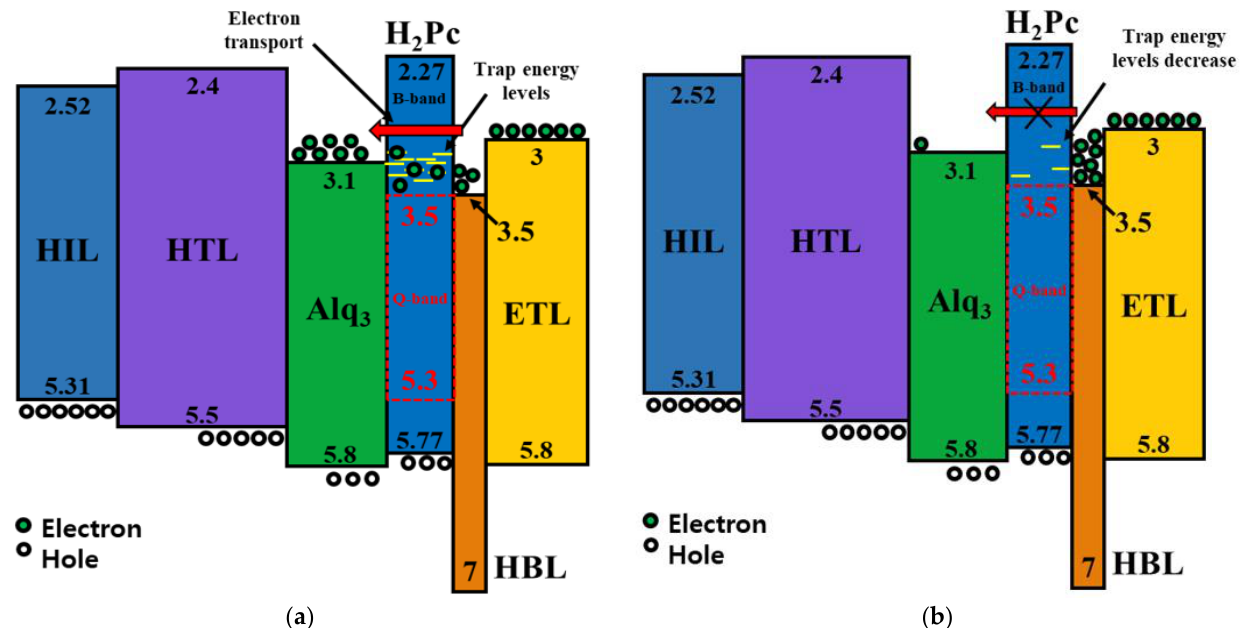
Figure 9. Atomic force microscope (AFM) images of H 2 Pc thin film with a thickness of 5 nm. ( a ) as- dep and ( b ) 120 °C thermal treatment for 30 min.